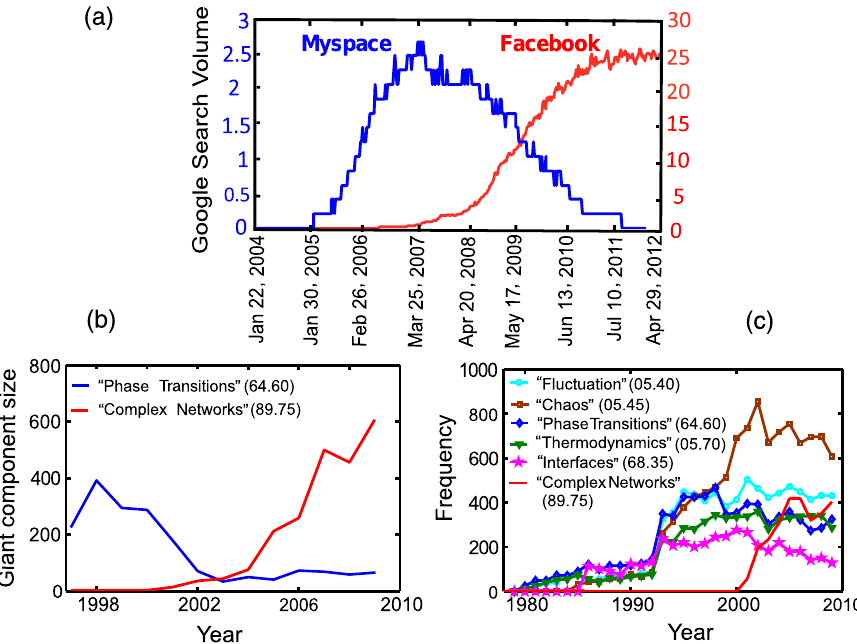
FIG. 1. Rise and fall of communities. (a) Comparison of activity on Myspace versus Facebook from 2004 to 2012 through Google ’ s Search Volume Index [12], which measures the number of Google searches of each word. The fall of Myspace coincided with the rise of Facebook, suggesting that users moved from one network to the other. The tipping point can be identified on March 25, 2007. (b) The size of the largest (giant) connected components of scientists studying “ Phase Transitions ” (PACS 64.60) and “ Complex Networks ” (PACS 89.75) from 1997 to 2009. The steady increase in the study of “ Phase Transitions" declined as the “ Complex Networks ” field started to grow in the physics community. (c) The frequency of citations per year of the top five fields of contributing scientists to the rise of “ Complex Networks ”